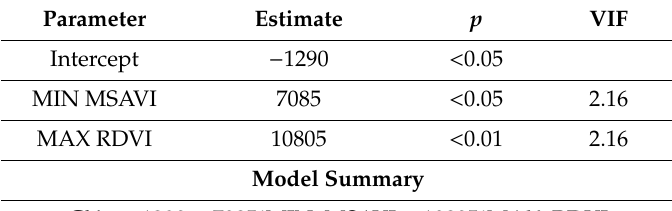
Table 7. Multilinear stepwise equation estimating grain yield (GY) using two (MIN MSAVI and MAX RDVI) variables. Stepwise equation estimate, p -value and variance inflation factor (VIF) are shown together with the summarized equation. The model was developed with data from the 2018 wheat growing season at the indicated fields shown in Figure